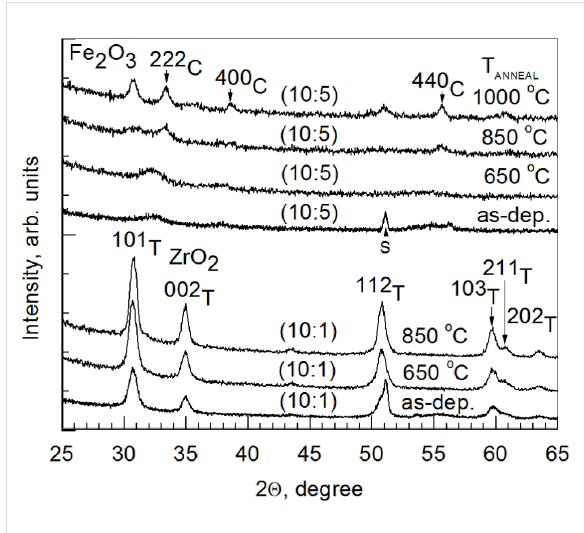
Figure 3: Grazing incidence X-ray diffraction (XRD) patterns for ZrO 2 /Fe 2 O 3 films deposited on Si(100) with ZrO 2 /Fe 2 O 3 cycle ratios and annealing temperatures indicated in the labels. The Miller indices are attributed to corresponding tetragonal (T) and cubic (C) phases of pure ZrO 2 and Fe 2 O 3 ,